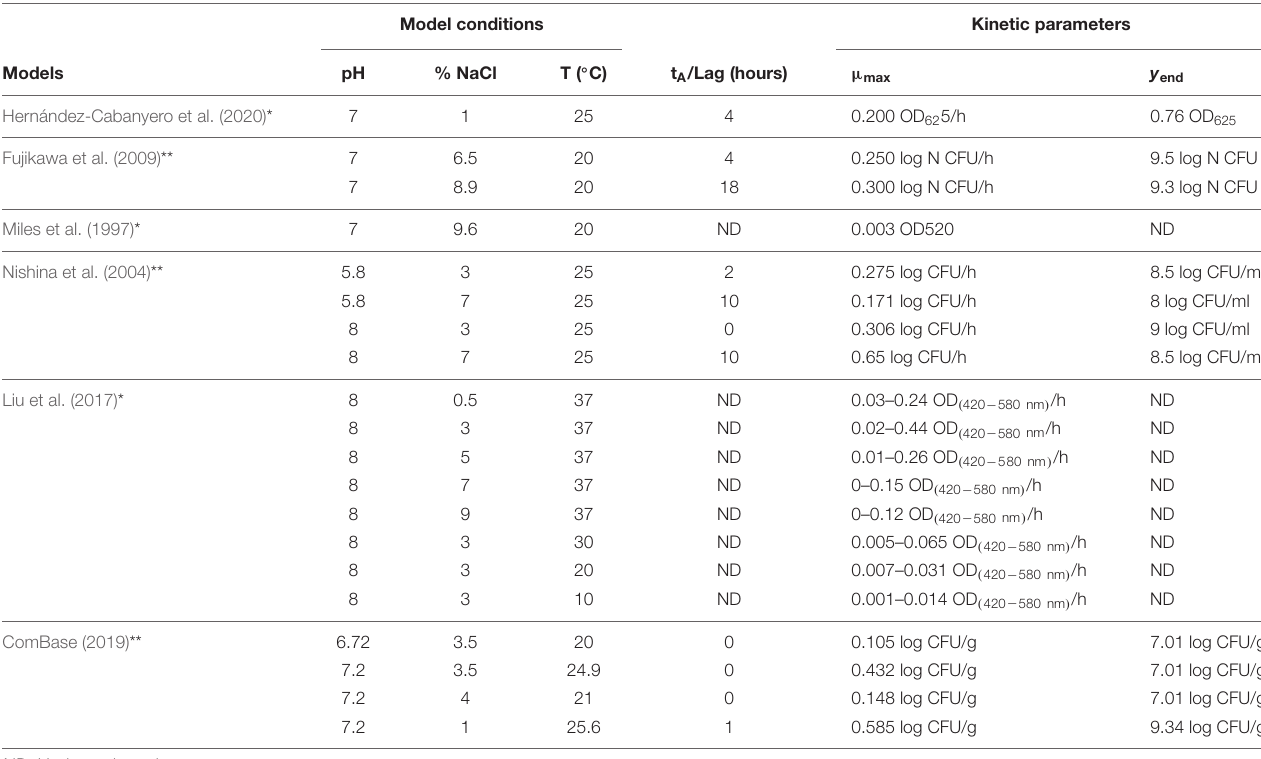
TABLE 5 | Comparative summary of other predictive models of Vibrio spp.